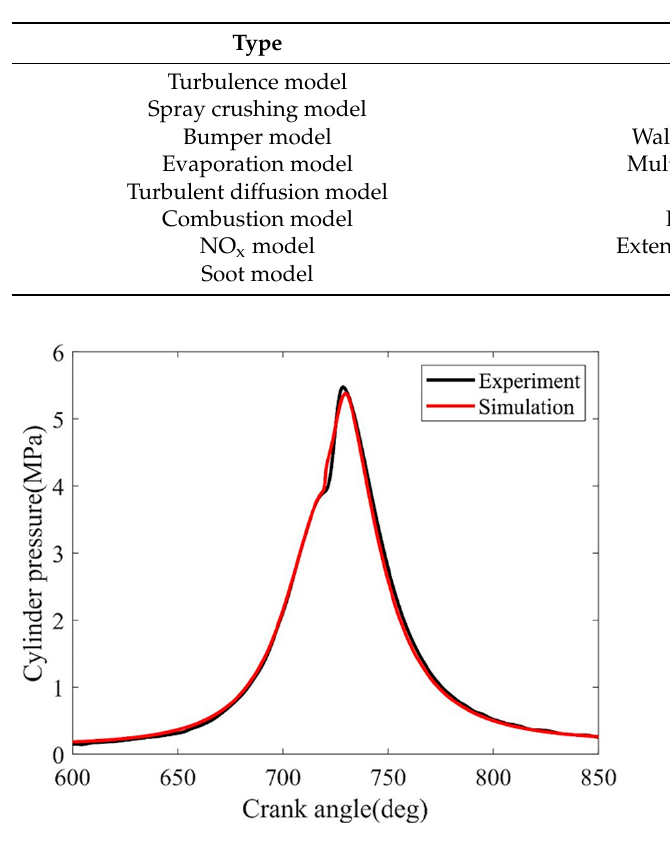
Figure 3. Engine validation results for cylinder